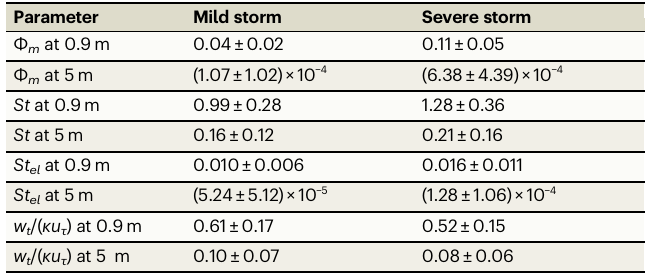
Table 2 | Key particle parameters of the mild and severe dust storm